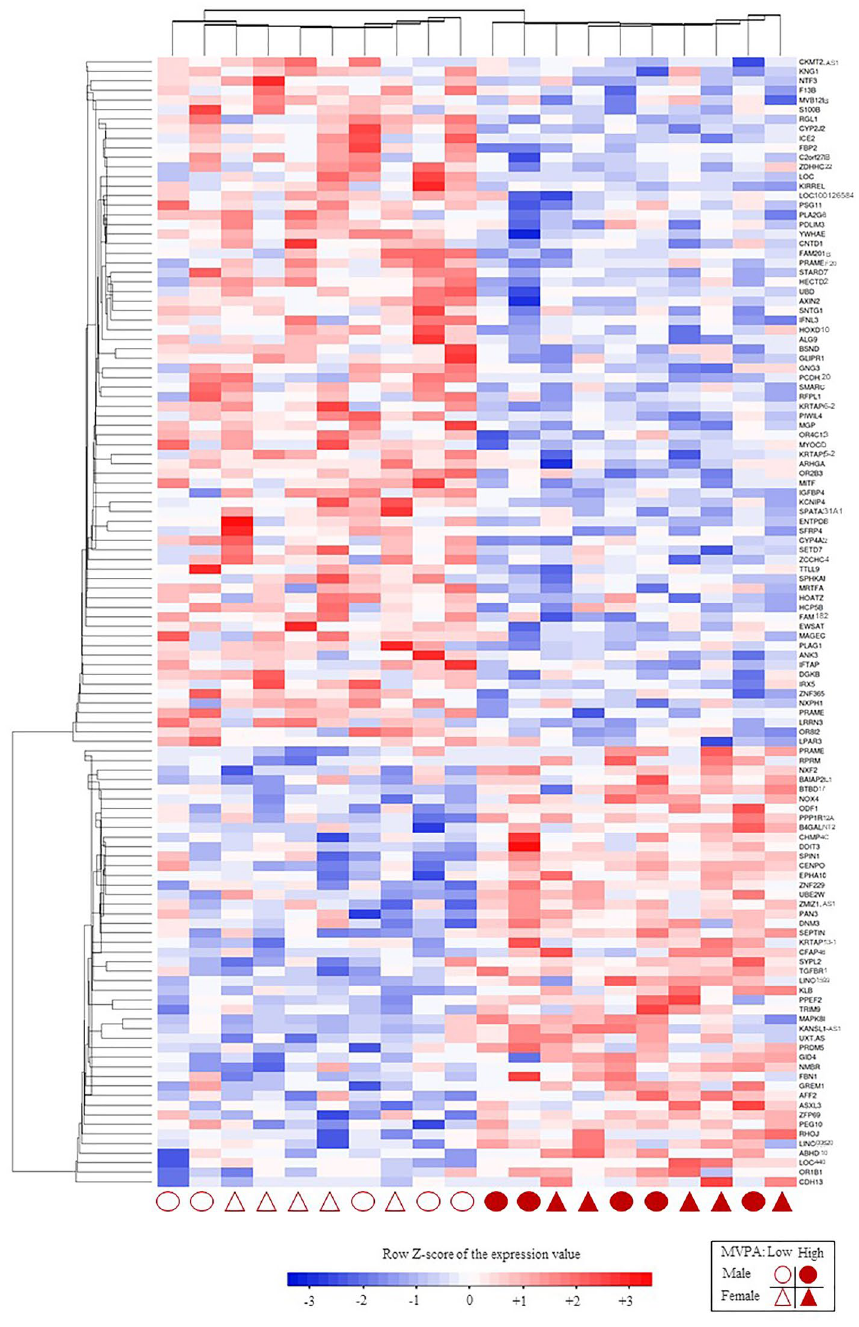
Figure 2. Heatmap representing individual expression data of genes differentially expressed in PBC between children with low and high MVPA levels from the IDEFICS study Spanish cohort. Rows represent the set of 118 differentially expressed genes with known function. Hierarchical centroid linkage (with Pearson distance) was the clustering method selected. Columns represent log2-transformed gene expression values for each gene in every single subject. Column (individuals) and row (gene expression) values were sorted by centroid linkage clustering method. The Heatmap has been generated with the "Heatmapper tool" (http:// www2. heatm apper. ca/ expre ssion/) 30